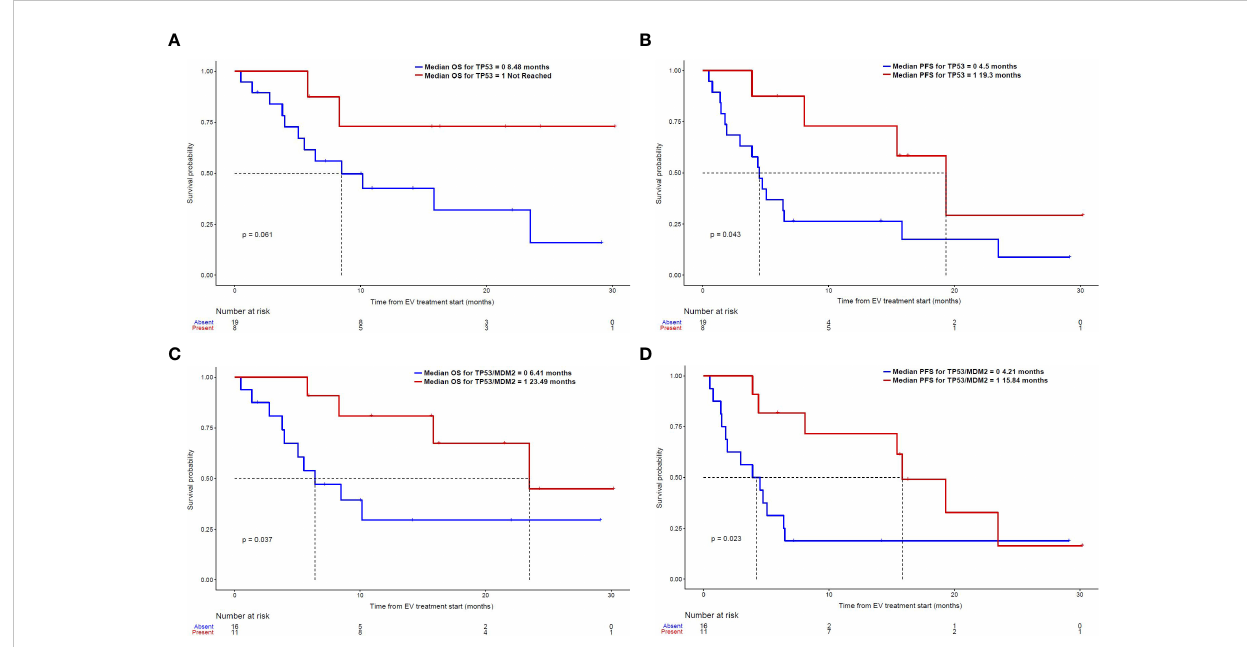
FIGURE 1 Kaplan-Meier curves: (A) OS and (B) PFS in patients with and without TP53 alterations; (C) OS (D) PFS in patients with and without the composite TP53/MDM2